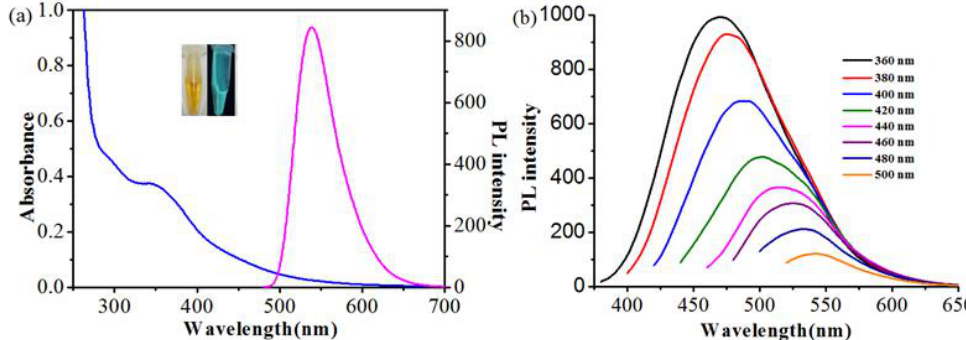
Figure 3. ( a ) UV-Vis spectrum and fluorescence emission spectrum of CDs/PNIPAM; ( b ) Fluorescence emission spectra of CDs/PNIPAM solution with different excitation wavelengths. Inset: Fluorescence image of the hydrogel under daylight (left) and 365 nm UV light (right).